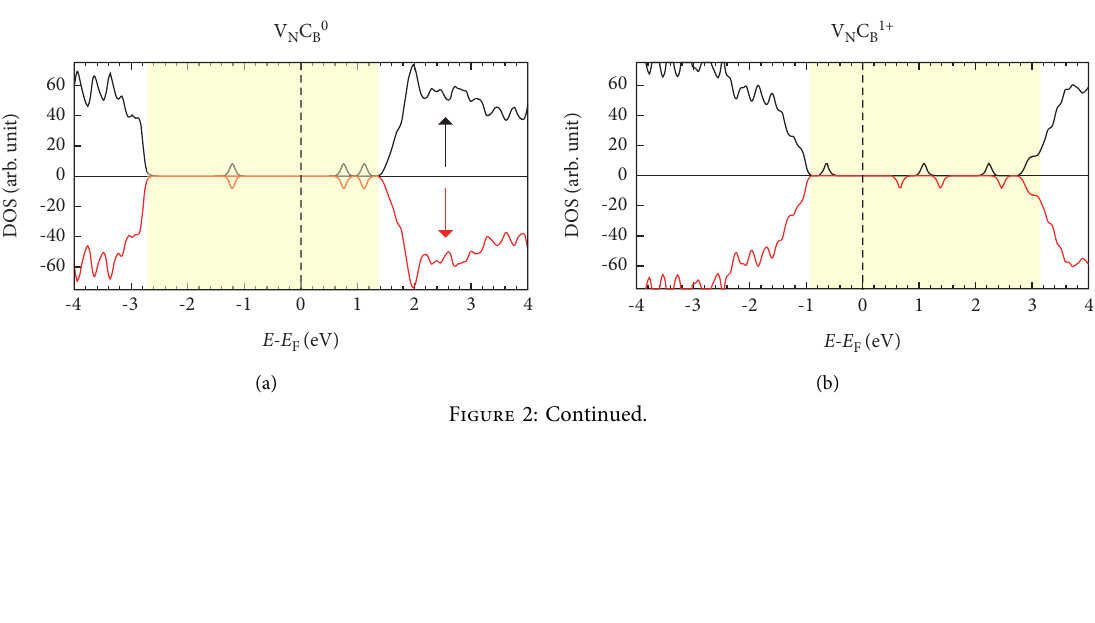
Figure 1: Optimized atomic structures of (a) neutral V each defect, the upper structure depicts the view in the out-of-plane direction, while the lower one is the side (in-plane) view. Distances between two atoms around the missing nitrogen atom are displayed in ˚A unit. In (c) and (d), the boron atom which protrudes out of the plane is shown in a color (pink) different from that of other boron atoms